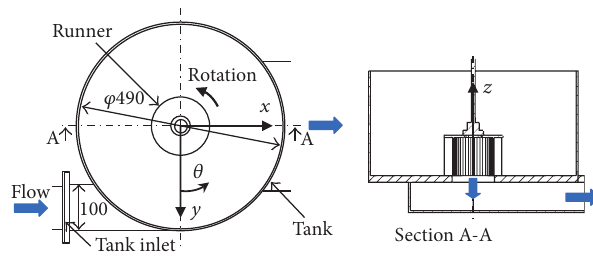
Figure 1: Test water turbine.